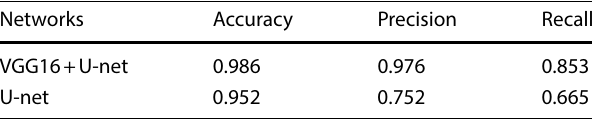
results of segmentation